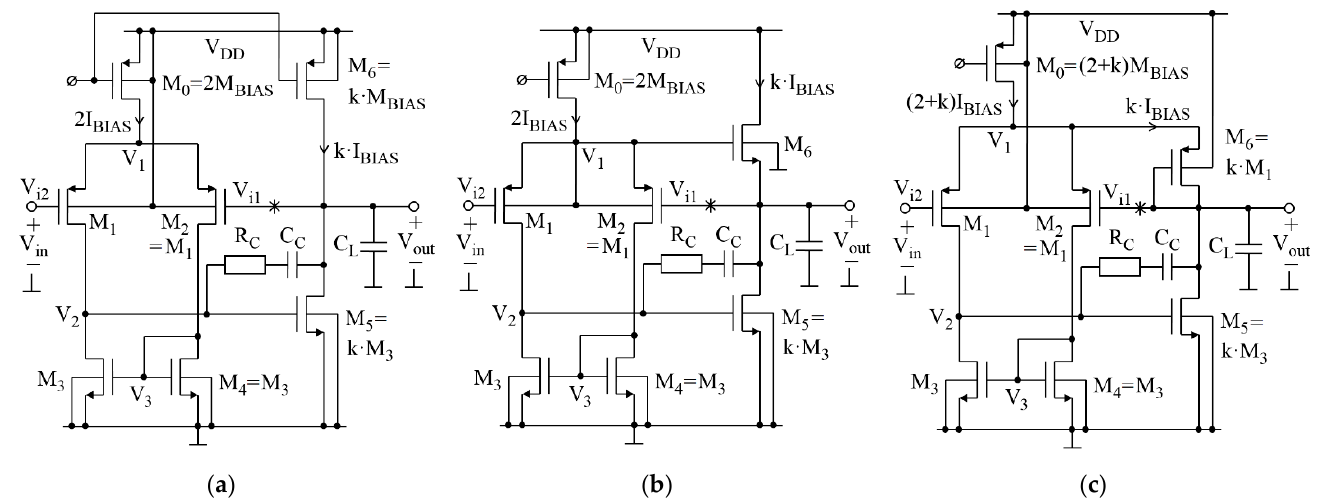
Figure 1. Unity-gain zero-offset buffers: ( a ) classic; ( b ) based on [1]; ( c ) proposed.